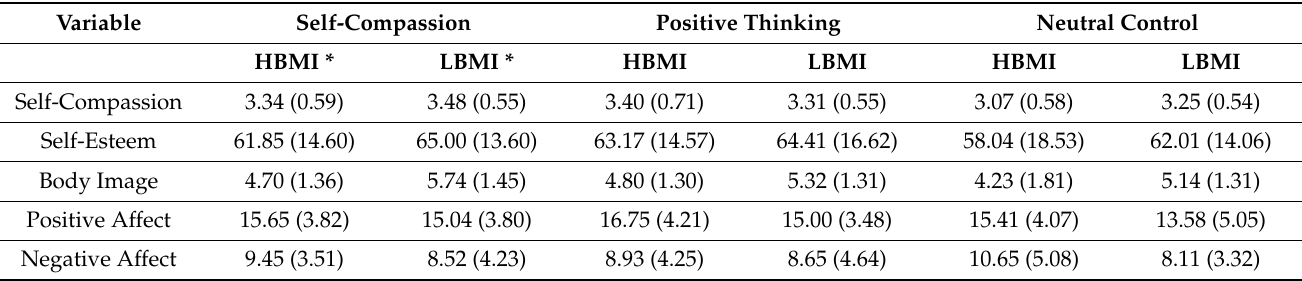
Table 2. Mean Scores (Standard Deviations) on Dependent Variables as a Function of Experimental Condition and Weight